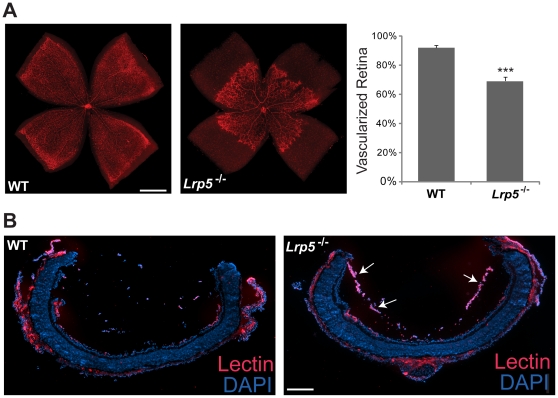
Delayed development of the superficial retinal vasculature and persistent hyaloid vessels in Lrp5 null mice.(A) Left: retinal whole mounts stained with isolectin B4-594 from WT and Lrp5 null mice at post-natal day (P) 8. Right: quantification of vascularized retinal area in WT and Lrp5 null mice at P8. n = 5–10 per group, ***p<0.001. (B) Retinal cross sections of WT mice and Lrp5 null mice at P8 stained for endothelial cells with isolectin B4-594 (red) and cell nuclei (DAPI, blue). Arrows indicate persistent hyaloid vessels in Lrp5 null retina. Scale bars: 500 µm.